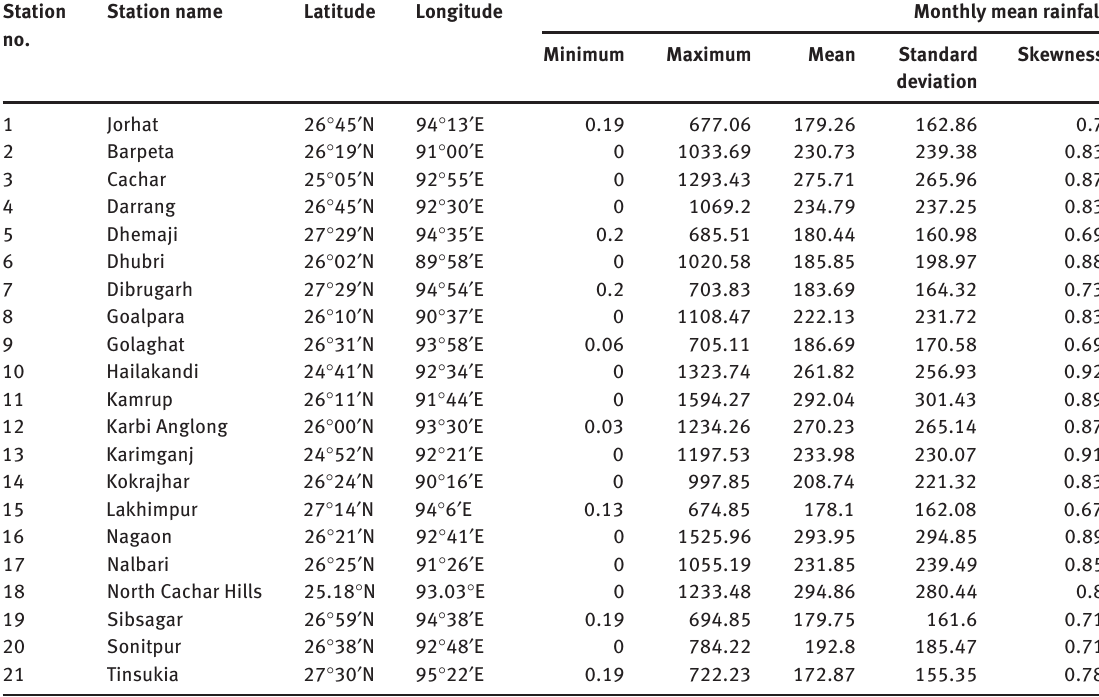
Table 1: Geographical Latitude, Longitude, and Rainfall Statistics of 21 Stations.